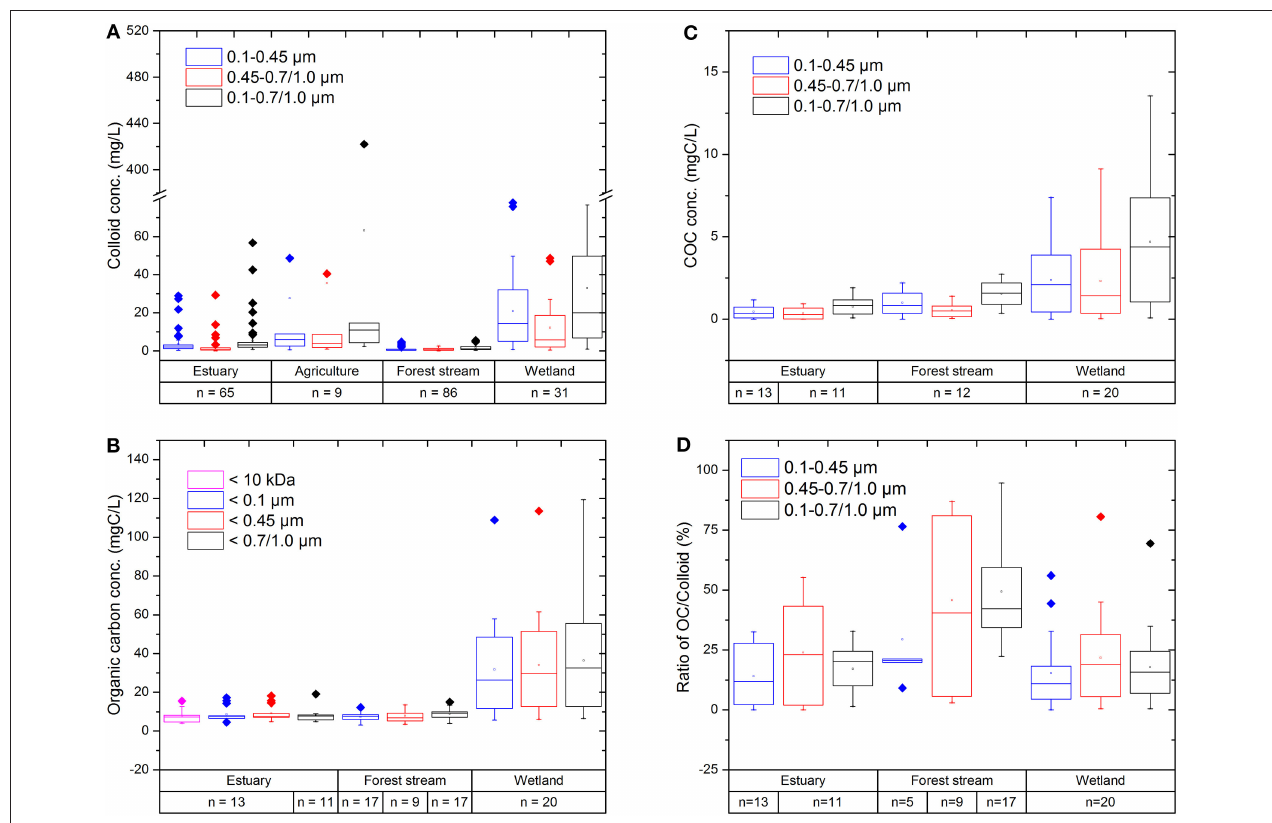
FIGURE 1 | Colloid and OC concentrations across ecosystems: (A) colloid concentrations in size fractions of 0.1–0.45, 0.45–0.7/1.0, and 0.1–0.7/1.0 µ m; (B) OC concentrations in size fractions of < 10 kDa, 0.1, 0.45, and 0.7/1.0 µ m in different natural systems; (C) COC concentration, and (D) %OC of colloids in size fractions of 0.1–0.45, 0.45–0.7/1.0, and 0.1–0.7/1.0 µ